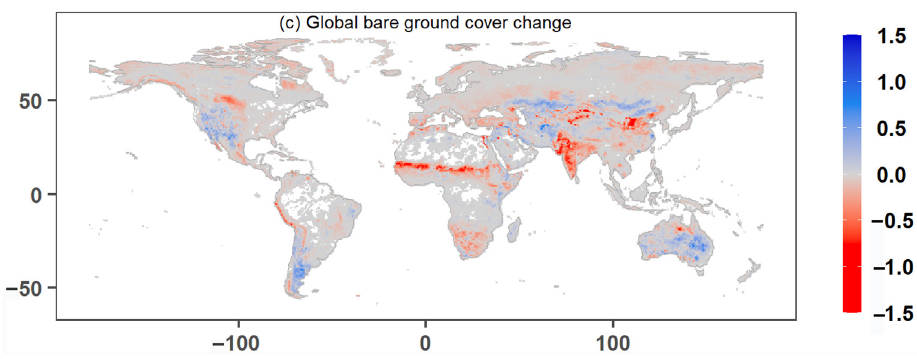
Figure 9. The trends in global land cover change for ( a ) tree canopy (TC), ( b ) short vegetation (SV), and ( c ) bare ground (BG) during 1982–2015.